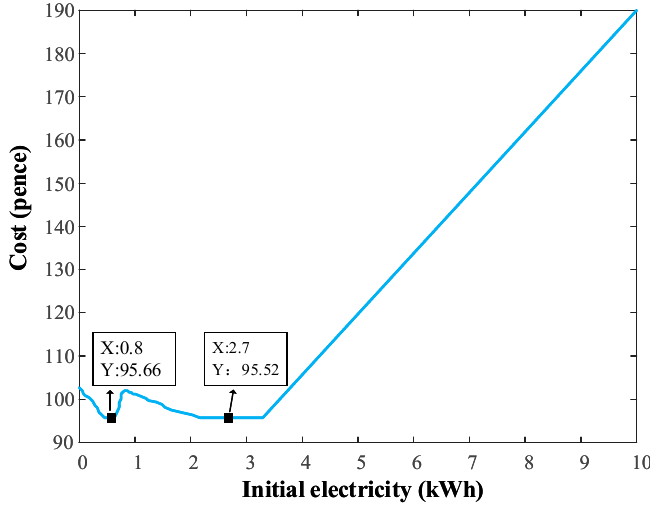
Figure 13. Battery initial energy in (kWh) vs domestic building daily electricity cost.